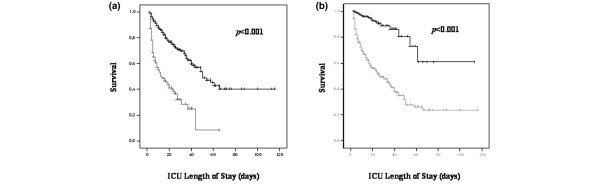
Independent risk factors for death in the ICU. Kaplan-Meier curves of critically ill patients with (grey) and without (black) central nervous system failure (a) and cardiovascular failure (b). ICU, intensive care unit.